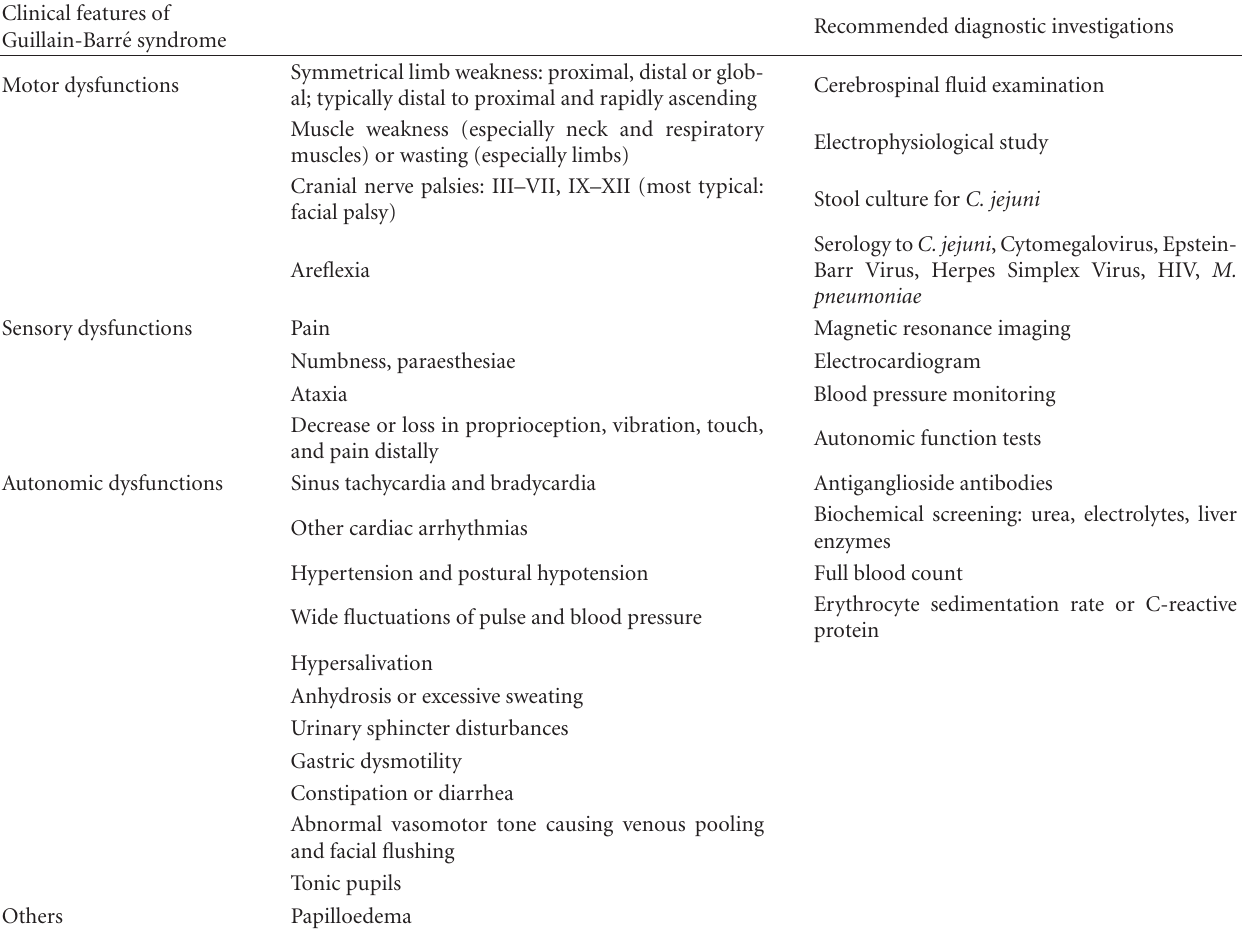
Table 1: Characteristics clinical features of Guillain-Barr´e syndrome and recommended diagnostic investigations. Clinical features